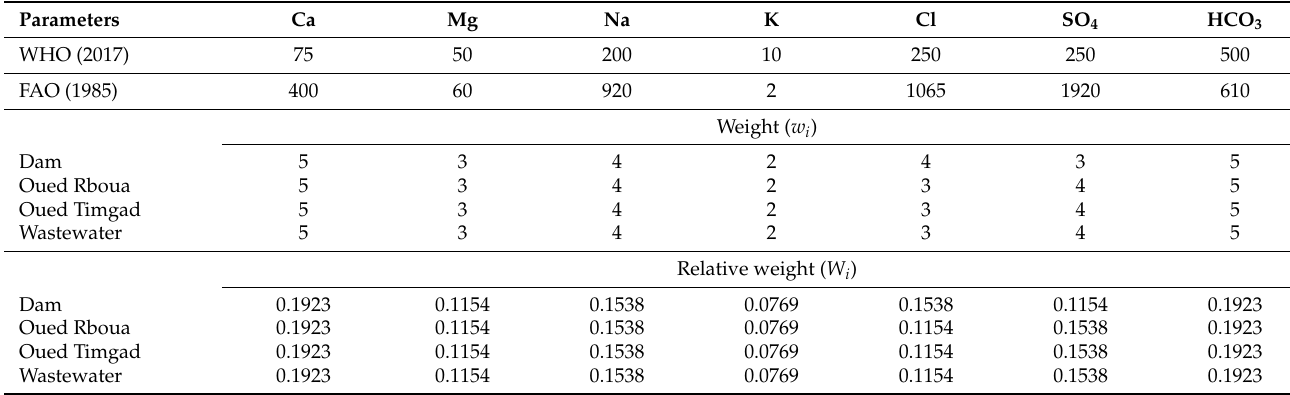
Table 4. Weight and relative weight of the hydrochemical